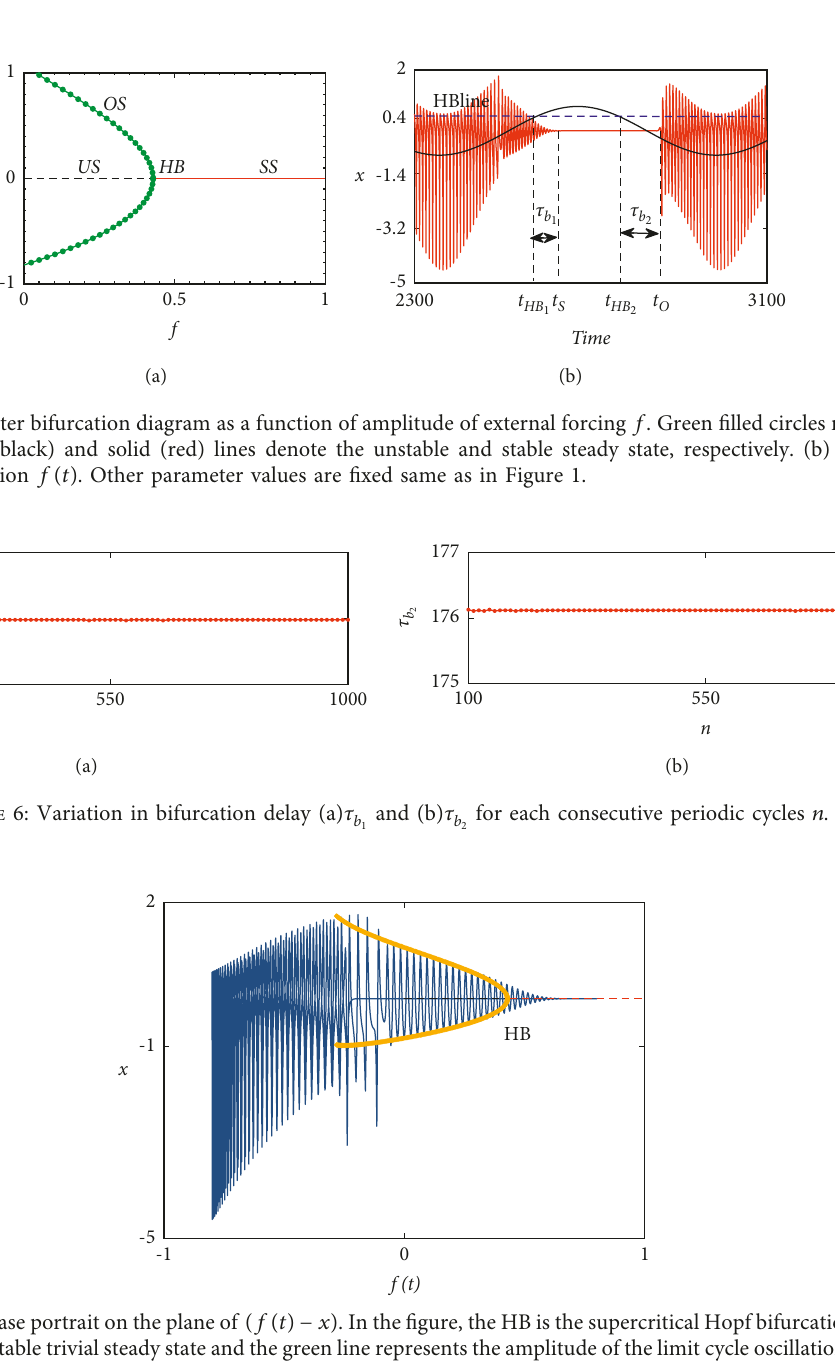
f t x . In the figure, the HB is the supercritical Hopf bifurcation point, where the ( ( ) − )